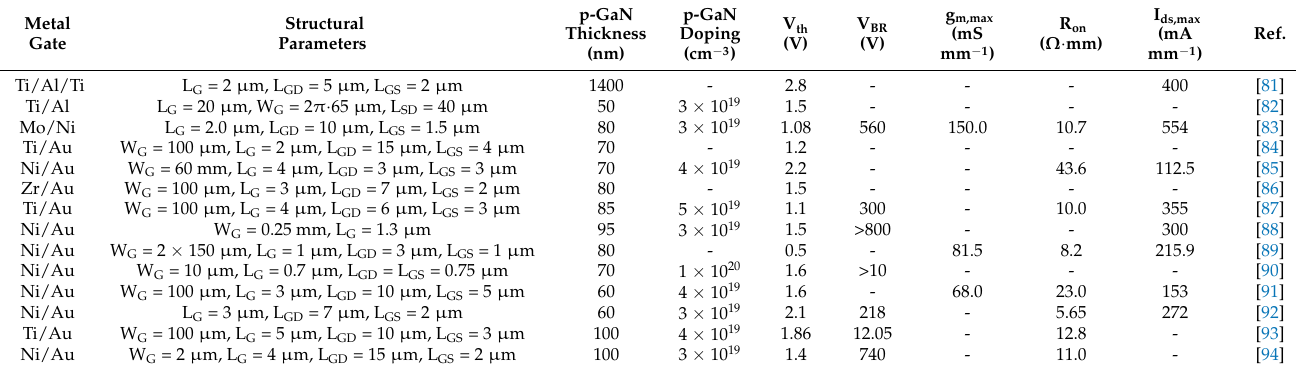
Table 2. Data for normally-off HEMTs with p-GaN gate, from recent literature. Metal